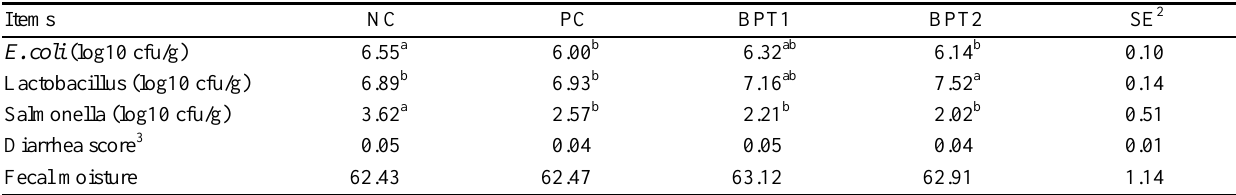
Table 5. Effects of bacterphage on fecal microflora and diarrhea score in growing pigs 1 Items NC PC BPT1 E. coli (log10 cfu/g) Fecal moisture